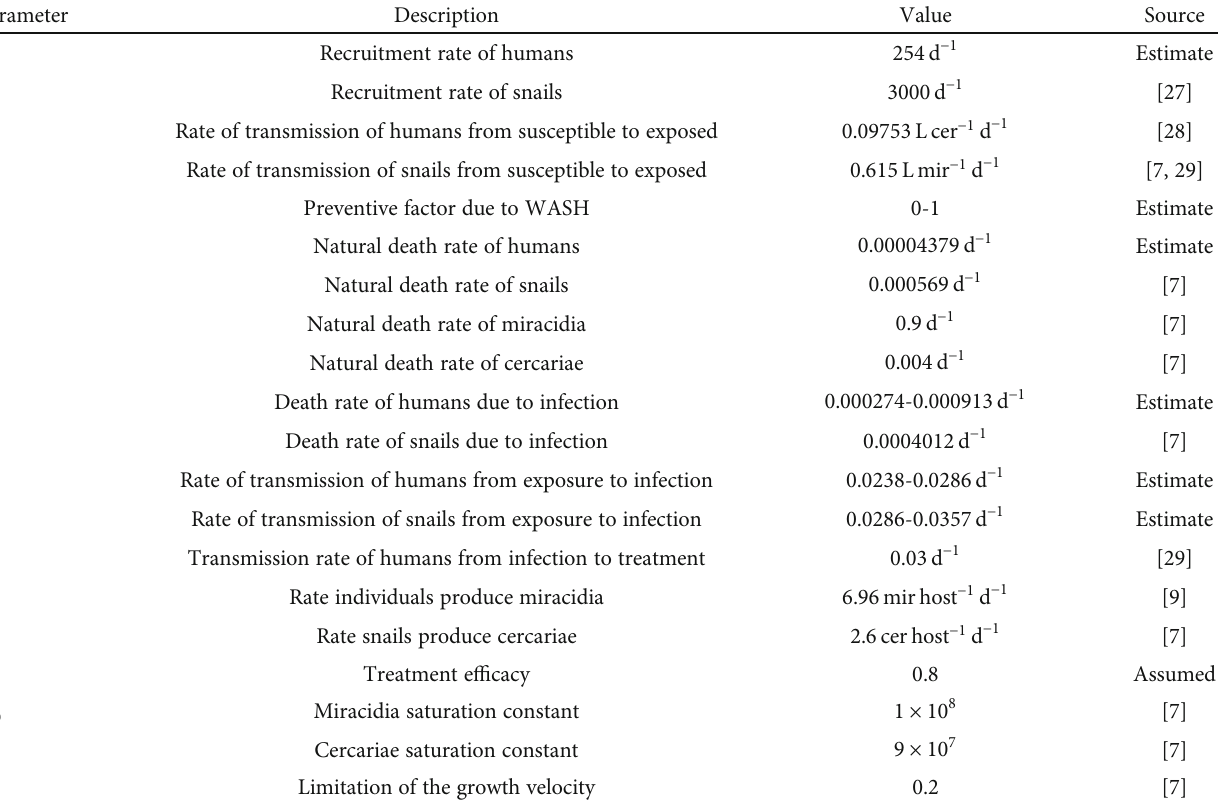
Table 1: A table showing the description of the model parameters and parameter